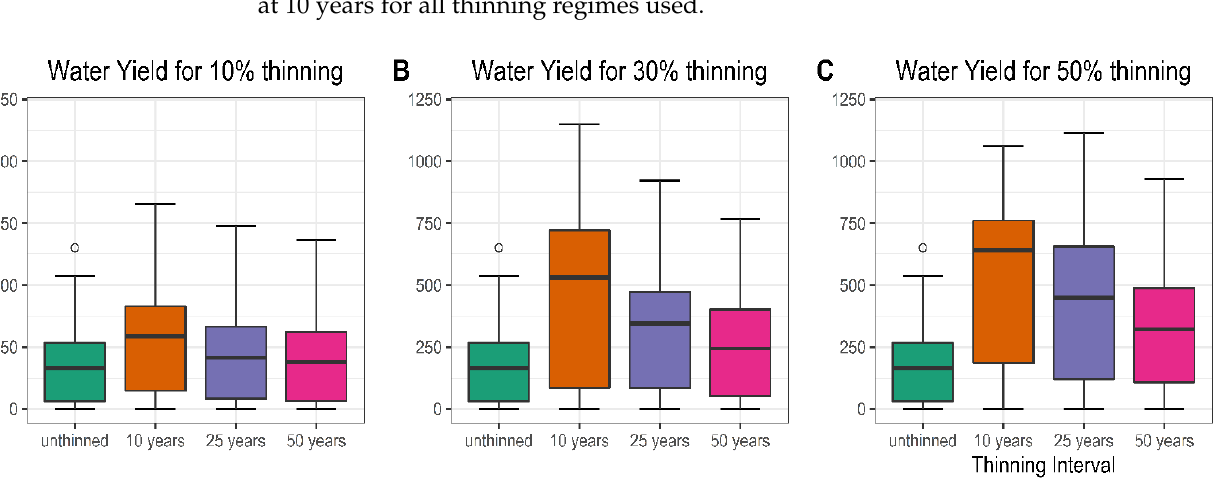
Figure 5. Boxplot for water yield for ( A ) 10%, ( B ) 30%, and ( C ) 50% thinning, respectively.